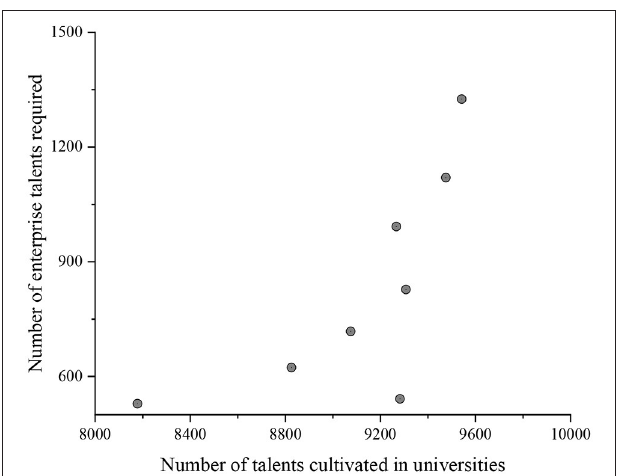
FIGURE 8 | Comparison between the mental health level of young entrepreneurs and the national norm.